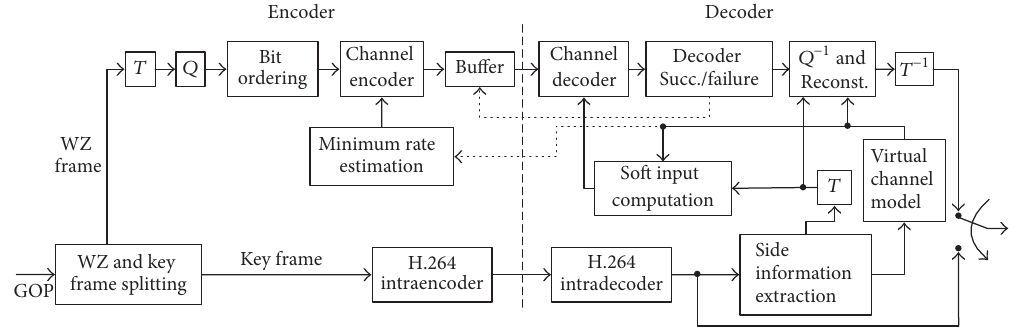
Figure 2: DISCOVER codec architecture.